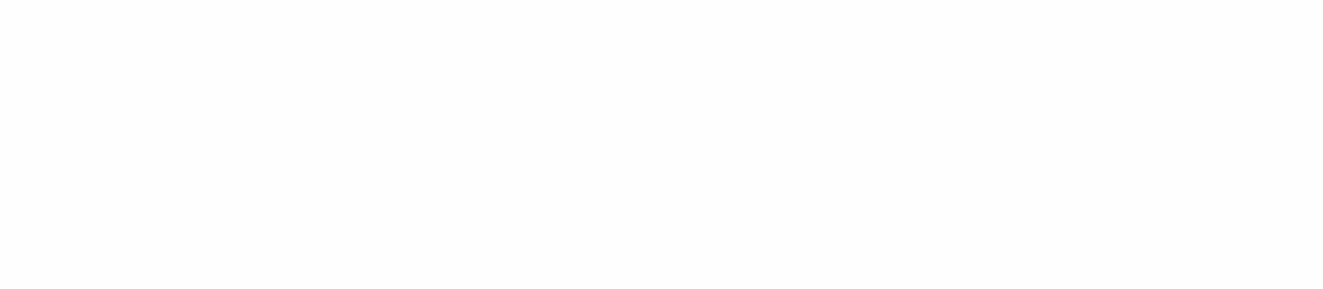
Fig. 8: Comparison between the maximum pressure in the calender annulus calculated in approximation with equation (first on this page) and the numerical results